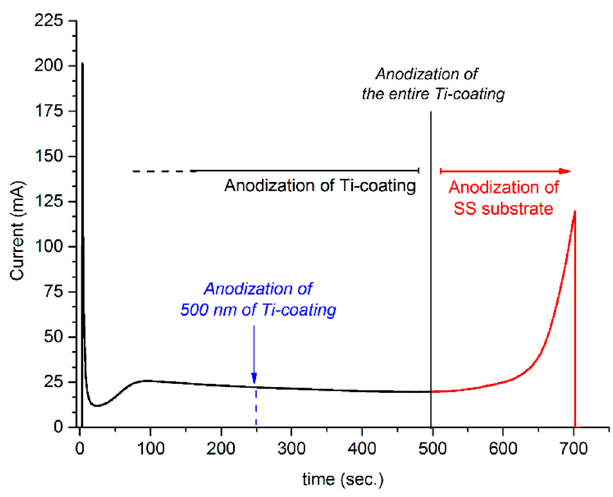
Figure 2. Time dependence of the anodization current.